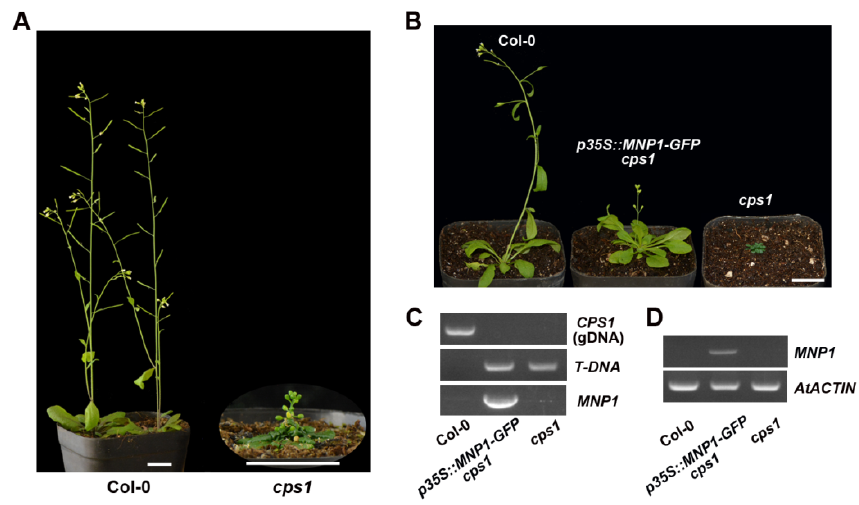
Figure 6. MNP1 partially rescued the mini-plant phenotype of Arabidopsis cps1 mutant. ( A ) The phenotype of Arabidopsis wild type (Col-0) and cps1 mutant. The Col-0 and cps1 mutant were 7 and 12 weeks old, respectively. Scale bar = 2 cm. ( B ) The p35S::MNP1-GFP transgenic plant of the cps1 homozygous background partially restored the mini-plant phenotype of cps1 mutant. The plants were 6 weeks old. Scale bar = 2 cm. ( C ) Genotyping of the transgenic plant. The homozygous T-DNA insertion in CPS1 / At4g02780 locus and MNP1 coding sequence were detected in the transgenic plant. ( D ) RT-PCR amplification of MNP1 from Col-0, the transgenic plant and cps1 mutant. AtACTIN was used as an internal control.